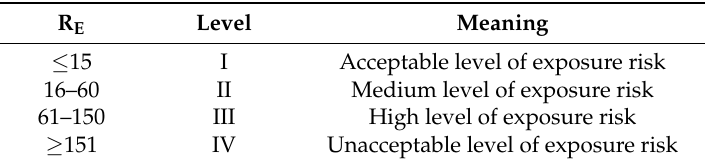
Table 10. Levels of the exposure risk (R E ).